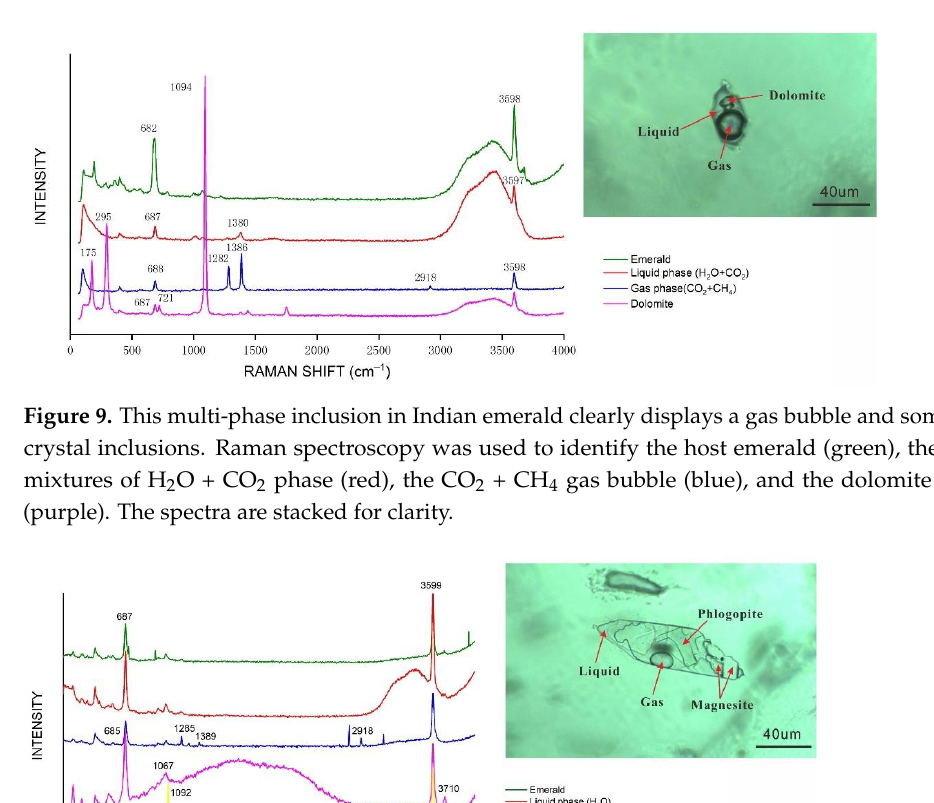
opite. 4.4. Spectroscopy 4.4.1. UV-Vis-NIR A representative UV-Vis-NIR e-ray spectrum from the emerald host with good trans- parency and clarity is shown in Figure 11. The narrow band at around 369 nm indicated the presence of Fe 3+ . The most prominent features in this group were the Cr 3+ bands at 426, 606, 635, and 680 nm. The wide absorption band at 851 nm is caused by different lattice sites occupied by Fe 2+ [3]. By comparing the UV-Vis-NIR absorption spectra of the same sample in different directions, it is found that the intensity of absorption peaks caused by different chromo- genic elements is different. The absorption intensities of Fe 3+ and Fe 2+ perpendicular to the c-axis were higher than those parallel to the c-axis. A distinct Fe 3+ absorption band was observed at 369 nm. Compared to Wood and Nassau (1968) [36] and Schmetzer et al. (1974) [37], the more typical characteristic of Indian emeralds is that the absorption strength of Fe 3+ and Fe 2+ is greater than that of Cr 3+ .